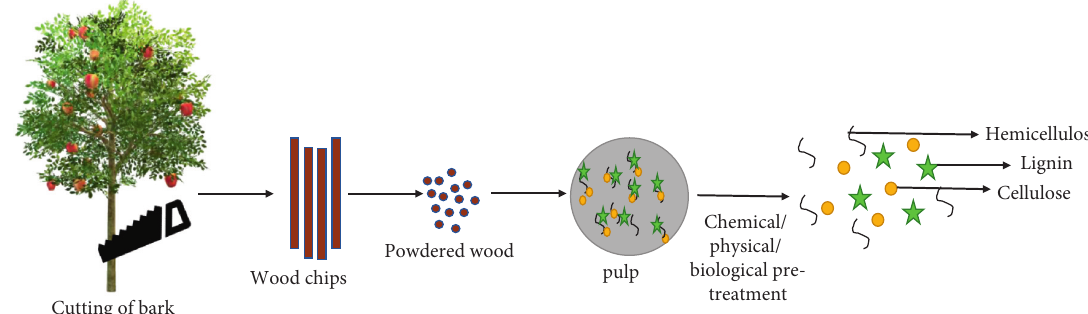
Figure 6: Illustration about the utilization of cellulosic fibres from wood of